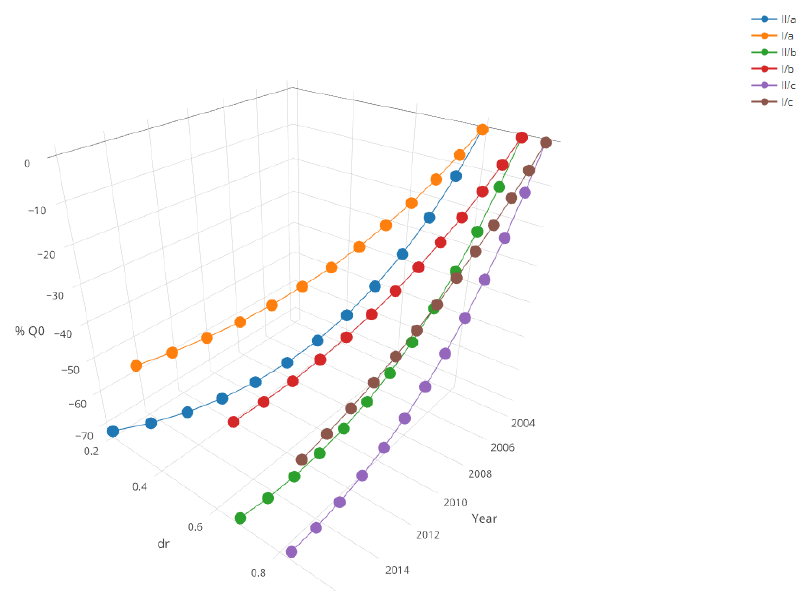
Figure 9. Percentage change in the capacity of floodplain areas for the analysed scenarios and test zones. Supplementary Materials include Figure 9 in an interactive form.